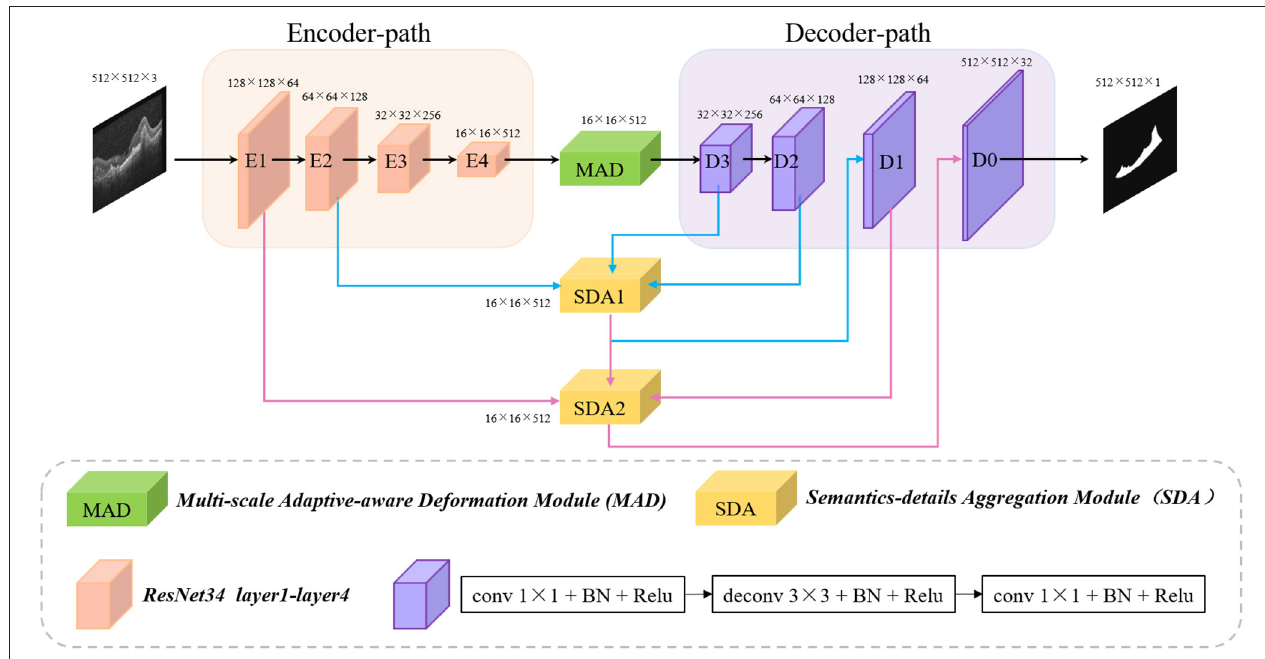
FIGURE 1 | Architecture of the proposed